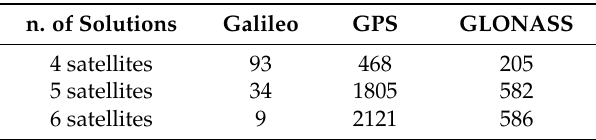
Table 2. Number of involved solutions for the simulated reduced operativeness (for GPS, GLONASS, and Galileo) in the subsequent